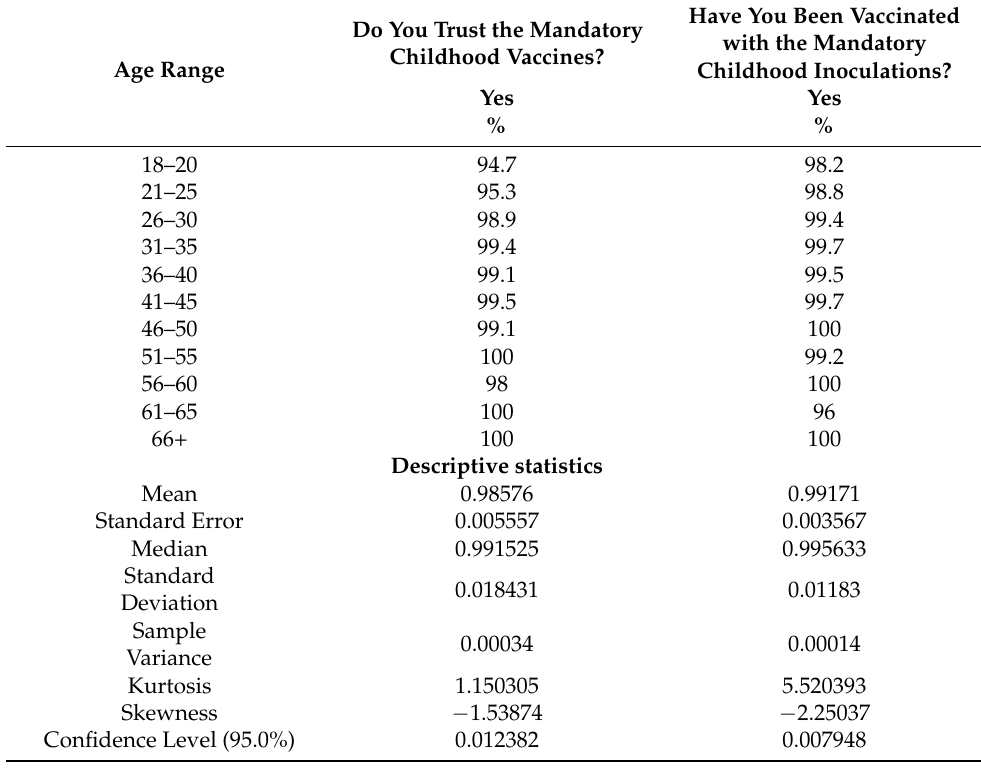
Table 3. Confidence and vaccination rate of participants in/with vaccines included in the national vaccination